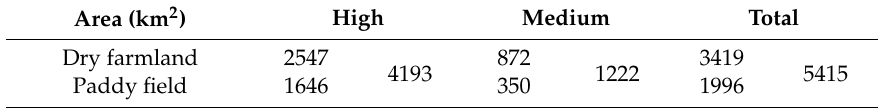
Table 4. Areal statistics of two rehabilitation priorities for wetland rehabilitation from